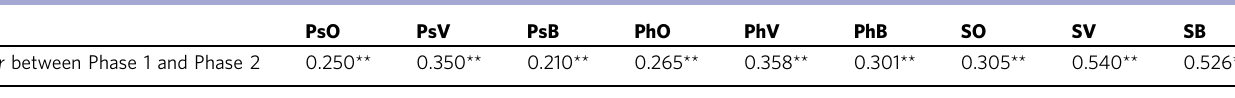
Table 3 Pearson ’ s correlation between ratings in Phase 1 and ratings in Phase 2.